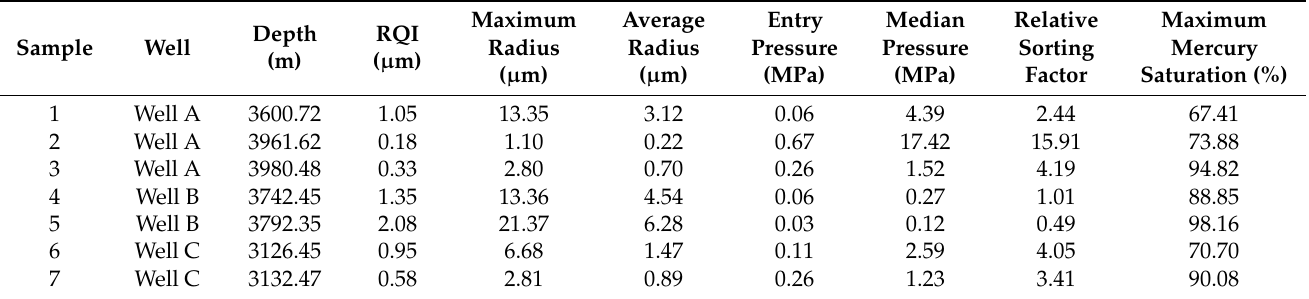
Figure 3. Relationship between porosity and permeability of the E 3 h tight sandstone reservoirs in Xihu Sag. Table 2. Microscopic pore structure parameters from HPMI analysis of E 3 h tight sandstones in Xihu